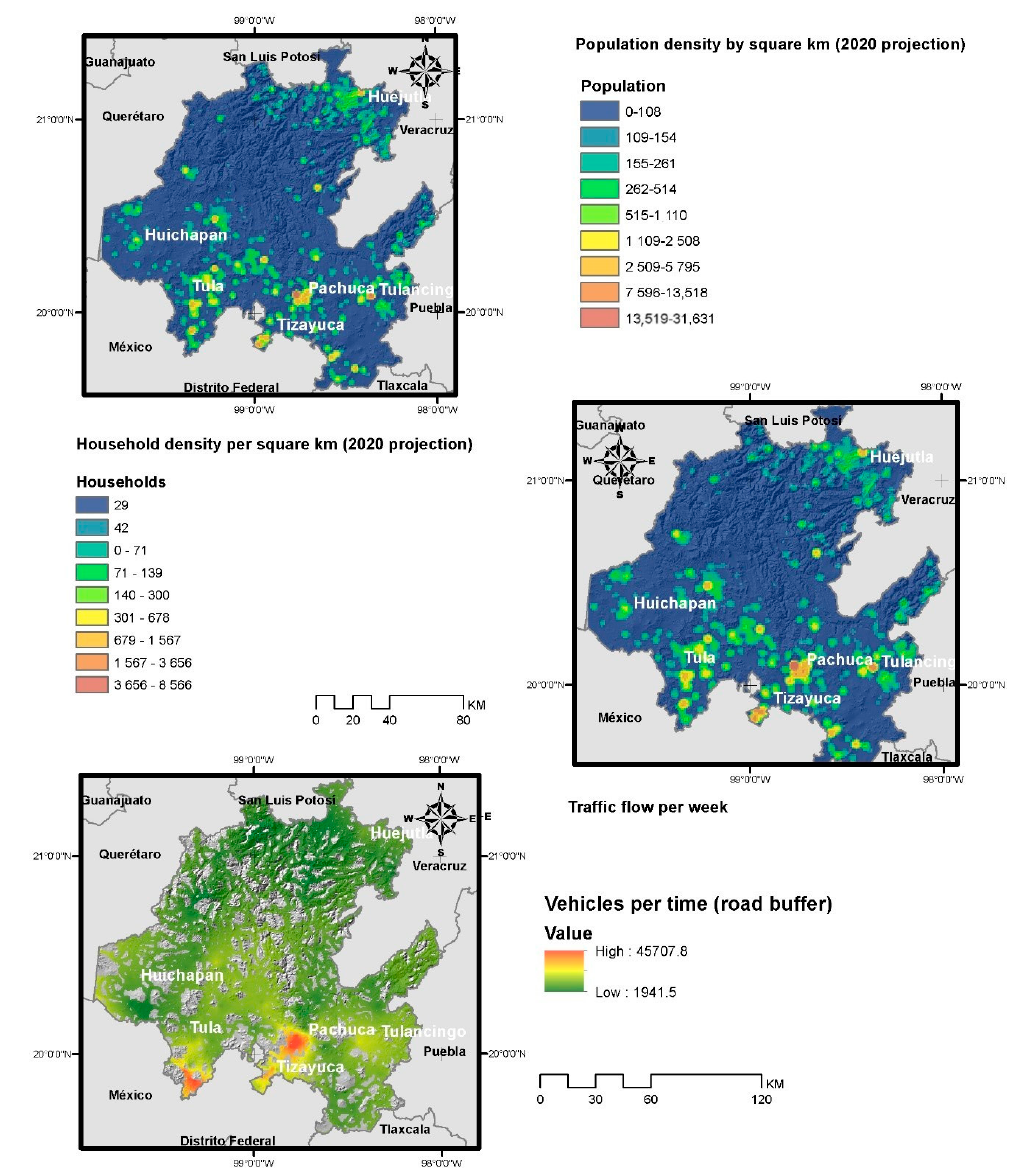
Figure 2. Geographical description of the variables related to density and that affect the level of contagion.